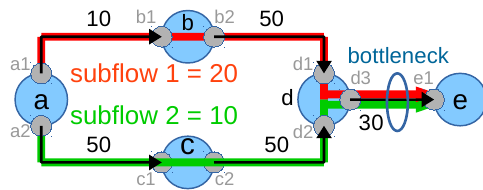
Figure 1. Example network to explain Definitions 1 to 5. Blue circles: nodes; grey dots: interfaces; black arrows/numbers: links with capacities; colored arrows/numbers: flows with capacity assignments. All numerical values are given in Mbps. Table 1. Connectivity matrix for example network in Figure 1. Rows: source, columns: destination. All values in Mbps. Zero values are omitted for better